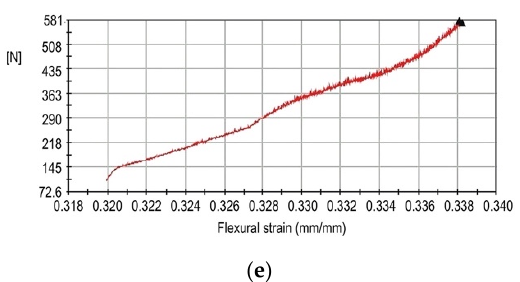
Figure 5. Flexural strain curves of restoration fabricated with different materials. ( a ) conventional (CV); ( b ) subtractive manufacturing (SM); ( c ) digital light processing (DLP); ( d ) stereolithography (SLA); ( e ) fused deposition modeling (FDM).